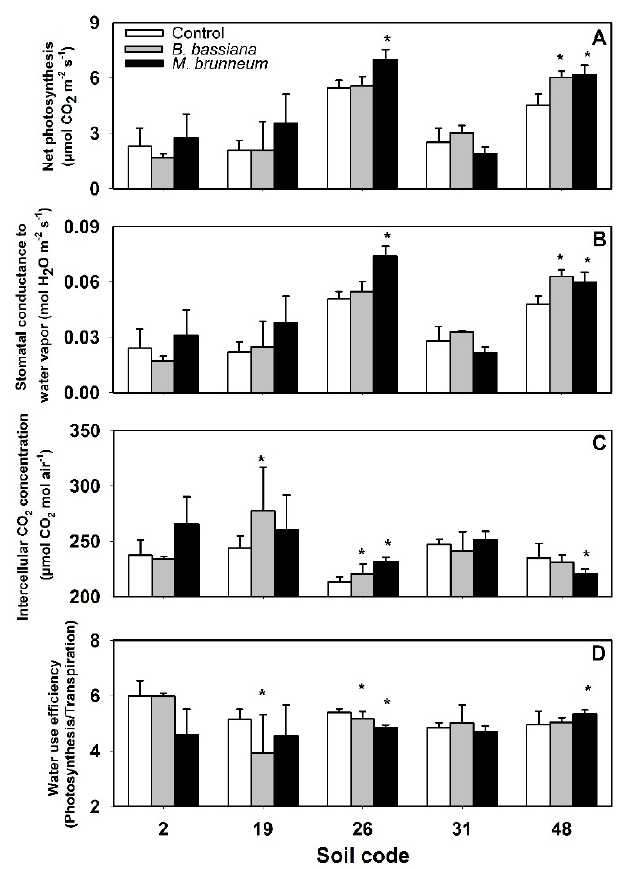
Figure 3. Repeated measures ANOVA (mean ± SE, n = 4) for net photosynthesis ( A ), stomatal conductance ( B ), intercellular CO 2 concentration ( C ) and water use efficiency ( D , WUE) in durum wheat plants as a function of fungal treatment and soil (No. 2, 19, 26, 31 and 48) 62 DAS. Asterisks (*) denote significant differences ( p < 0.05) between each fungal treatment and the Control plants.